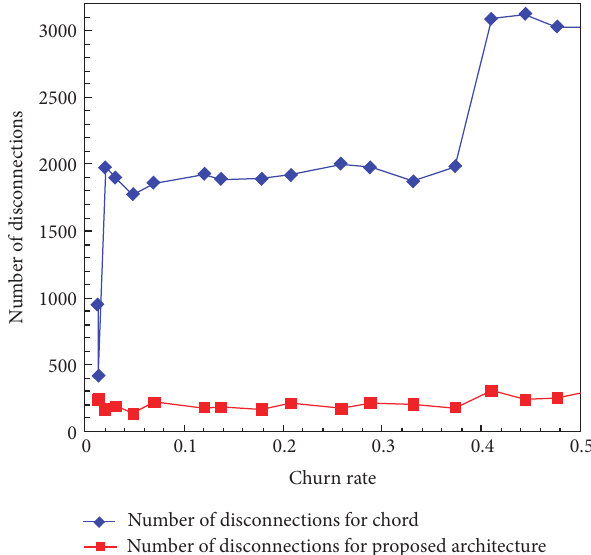
Figure 7: Effects of varying levels of churn on overlay network